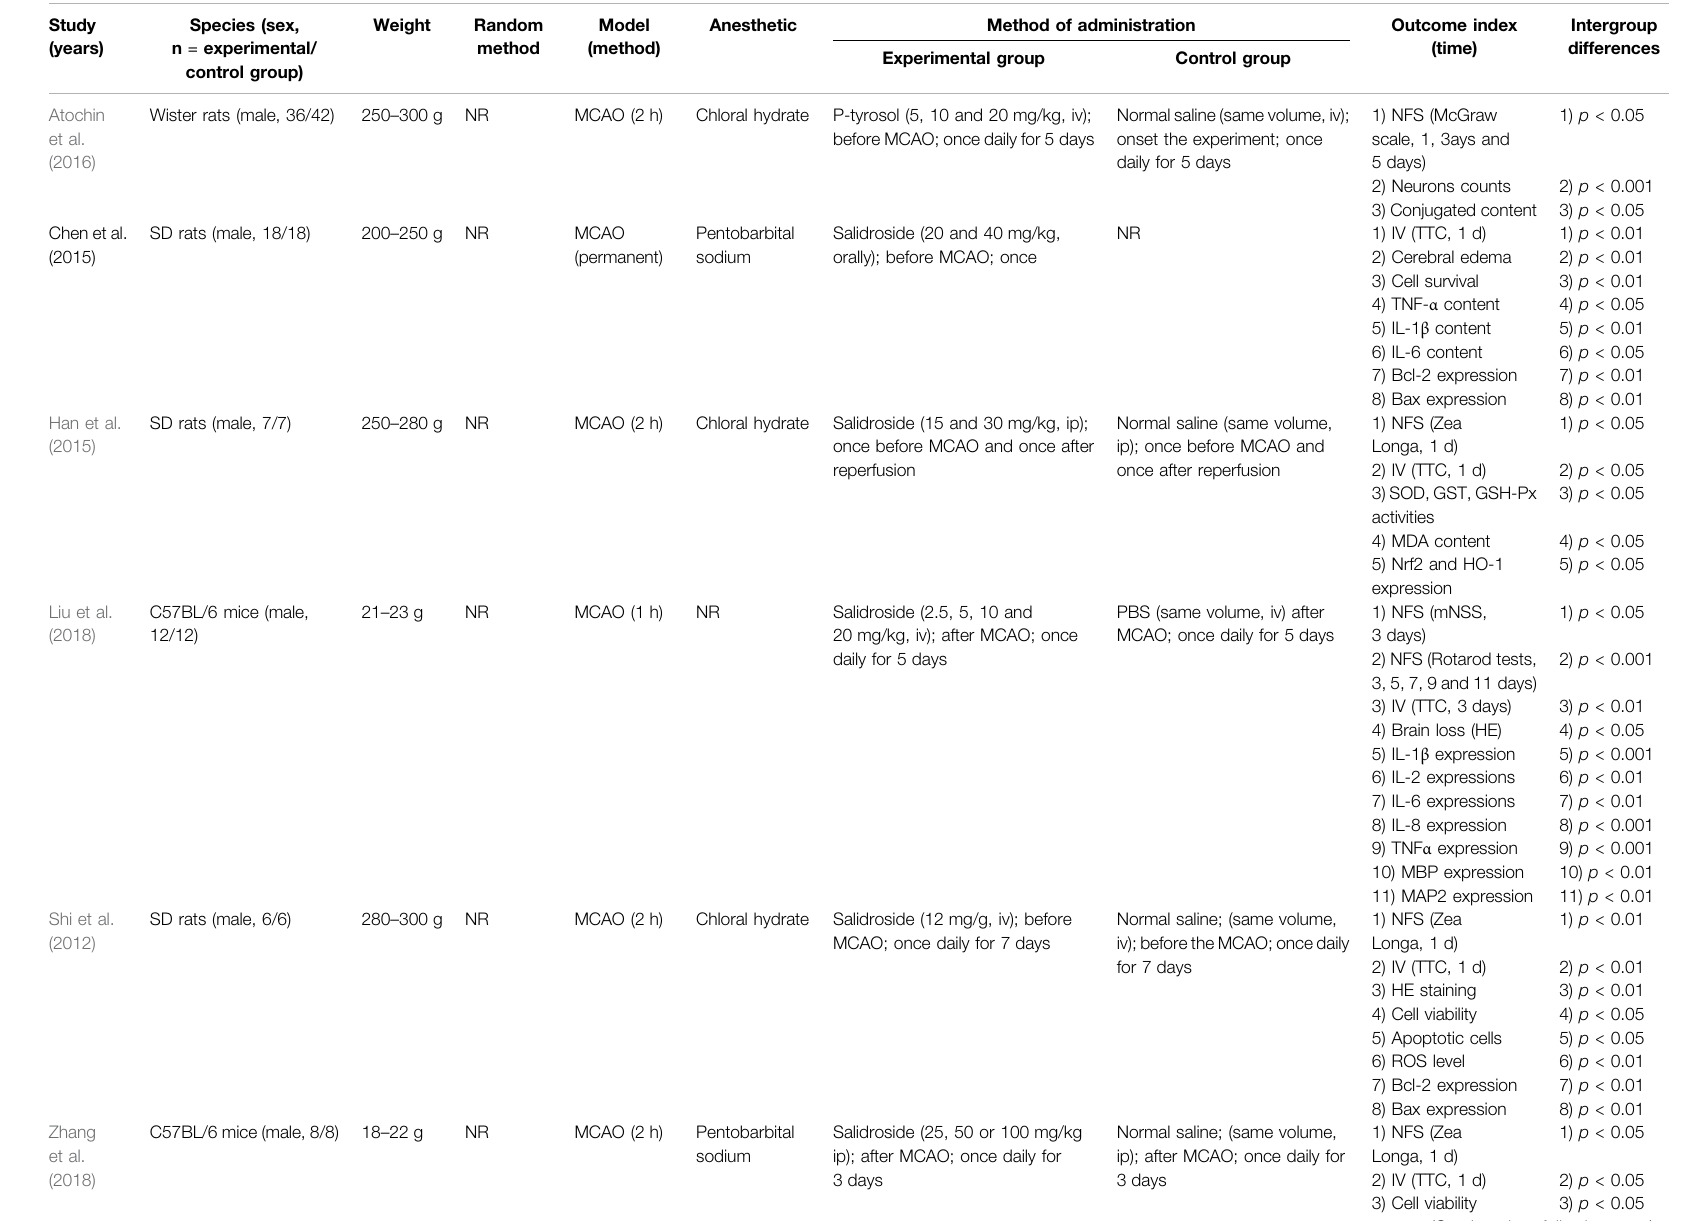
TABLE 1 | Basic characteristics of the included